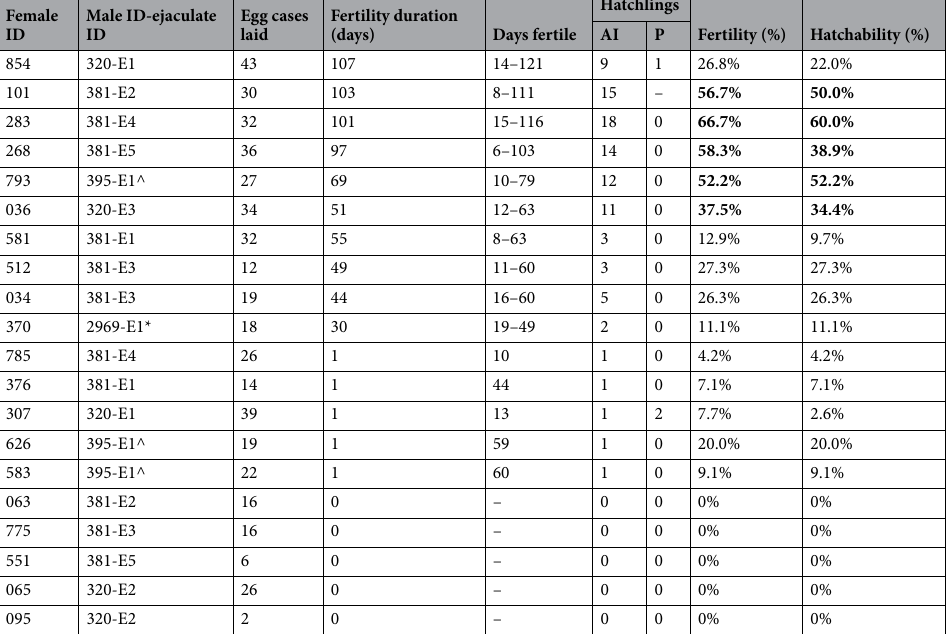
Table 3. Outcome of whitespotted bamboo sharks Chiloscyllium plagiosum artificial insemination trials. Hatchlings: developed from sexual fertilization (AI) or parthenogenetically (P) after artificial insemination. *Indicates semen shipped overnight from Adventure Aquarium, NJ, to Aquarium of the Pacific, CA, for artificial insemination. ^ Indicates semen shipped overnight from The Florida Aquarium, FL, to Ripley’s Aquarium of the Smokies, TN, for artificial insemination. Bold fertility and hatchability percentages indicate females where artificial insemination was confirmed bilaterally